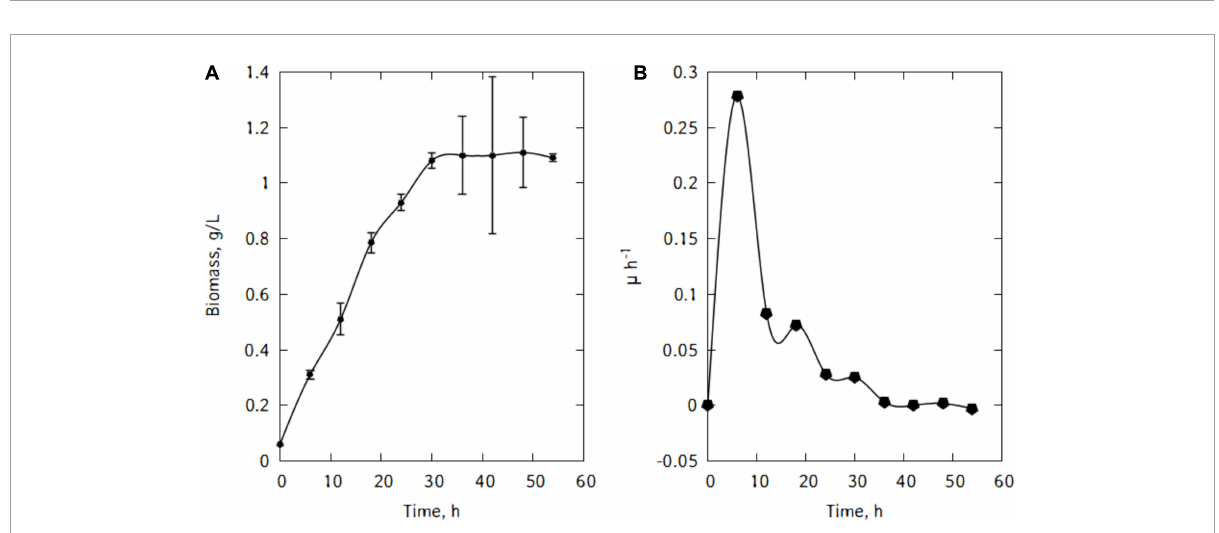
FIGURE4 Growth of L. casei in traditional cheese whey (A) , specific growth rate (B)